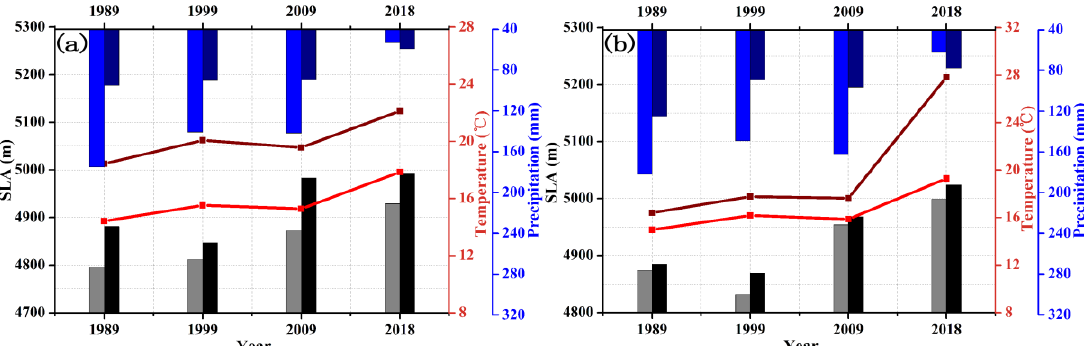
Figure 10. The glacier SLA in 1989, 1999, 2009 and 2018 (gray and black bars), summer temperature (red and dark red lines) and annual total precipitation (dark blue and light blue bars) on the south and north slopes ( a ), and on the east and west slopes ( b ), with light colors representing the north and east slopes (light gray, red and light blue), respectively. Dark colors represent south slope and west slope (black, dark red, dark blue).